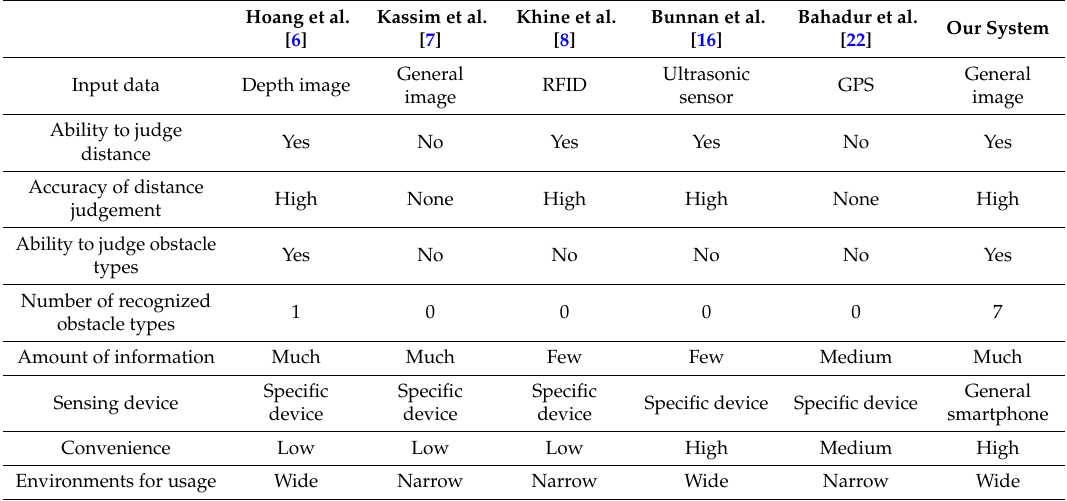
Table 3. Comparison between our proposed system and related